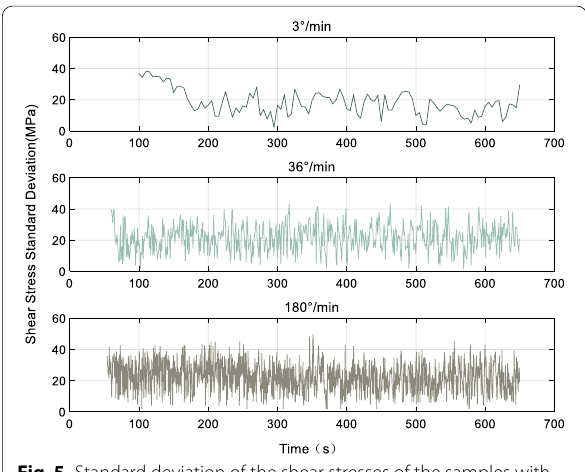
Fig. 5 Standard deviation of the shear stresses of the samples with